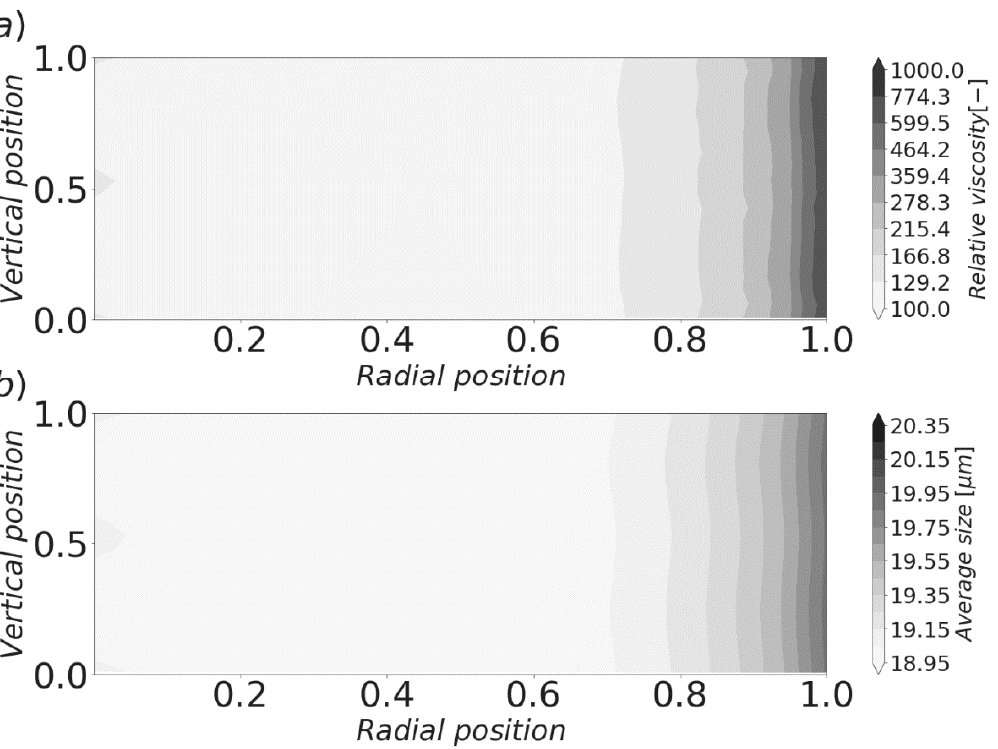
Figure 8. Local viscosity and average size profiles in a parallel-plates geometry. The rotating plate is located at the top. The center of the geometry is located on the left. ( a ) Relative viscosity profile. ( b ) Average size profile.